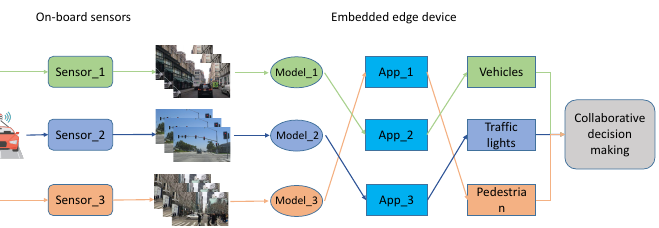
Figure 5. Optimized multi-model tasks scheduling-based object detection procedure.